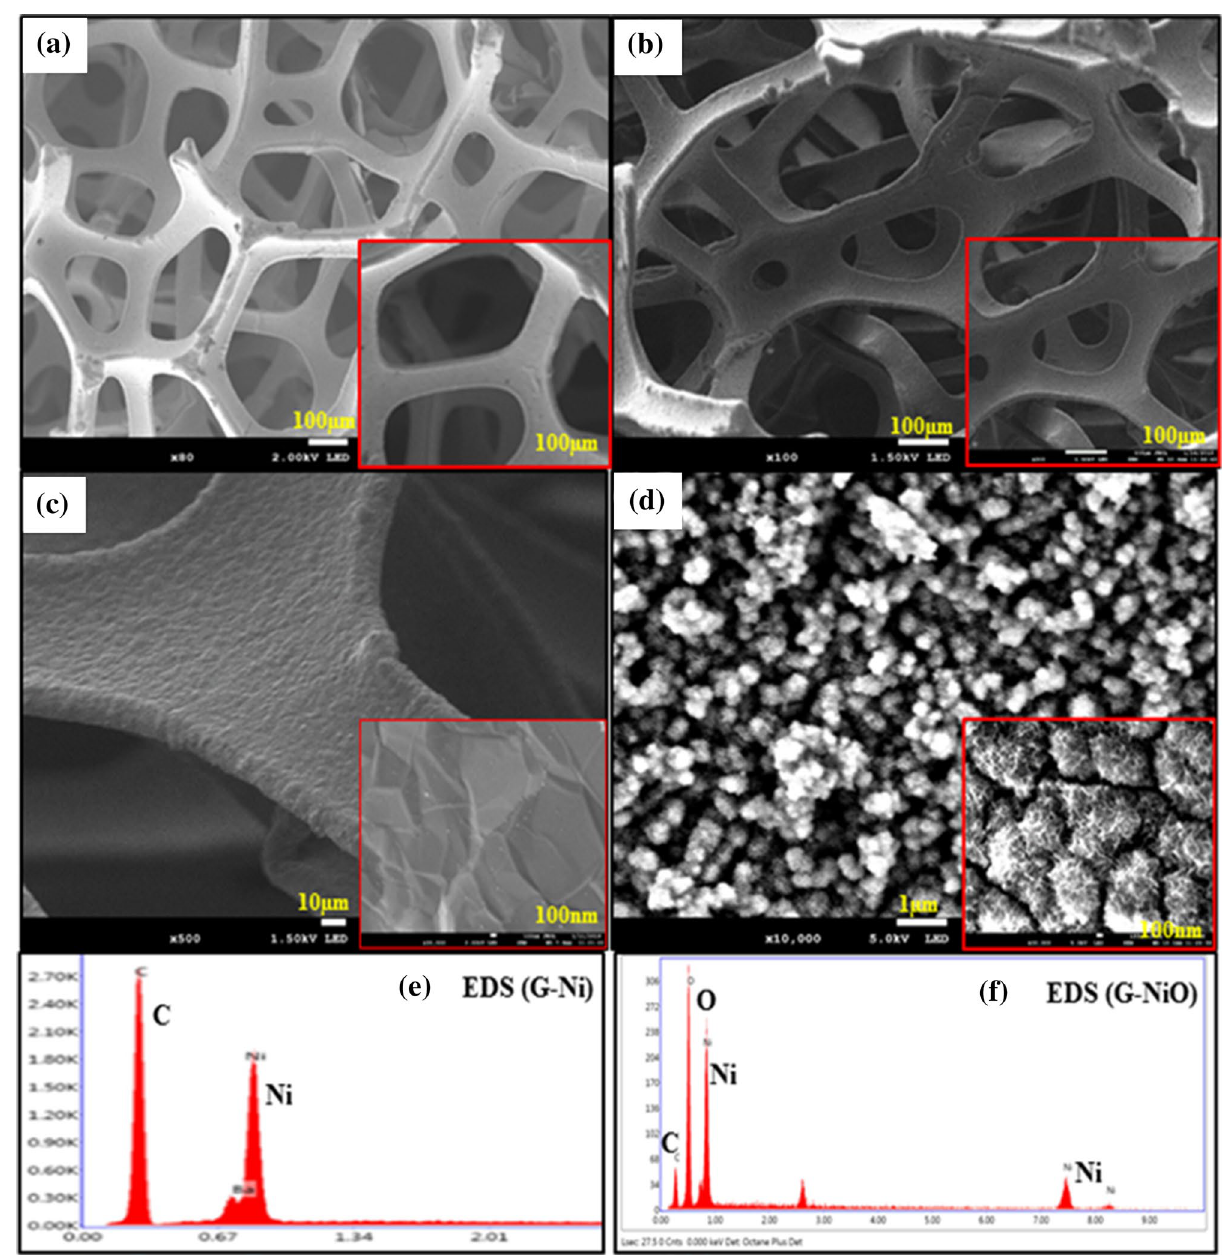
Figure 2. FESEM micrographs of ( a ) Ni foam, ( b , c ) G-Ni electrode, ( d ) G-NiO electrode; ( e ) corresponding EDS mapping for G-Ni electrode, and ( f ) corresponding EDS mapping for G-NiO electrode. The insets depict the corresponding high magnification images of the electrodes.